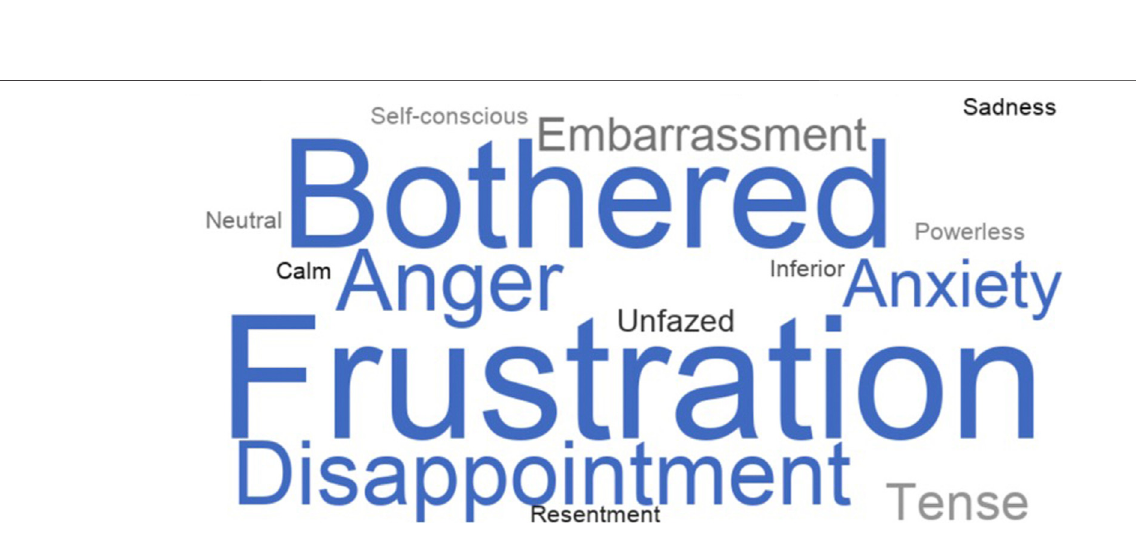
FIGURE 6 | Emotions experienced from Voice Technology Errors ( n (cid:1) 30).